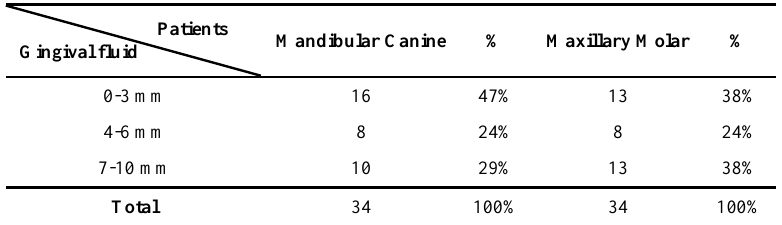
Table 7. The amount of gingival fluid shown in aggravation levels of the clinical situation, patients first